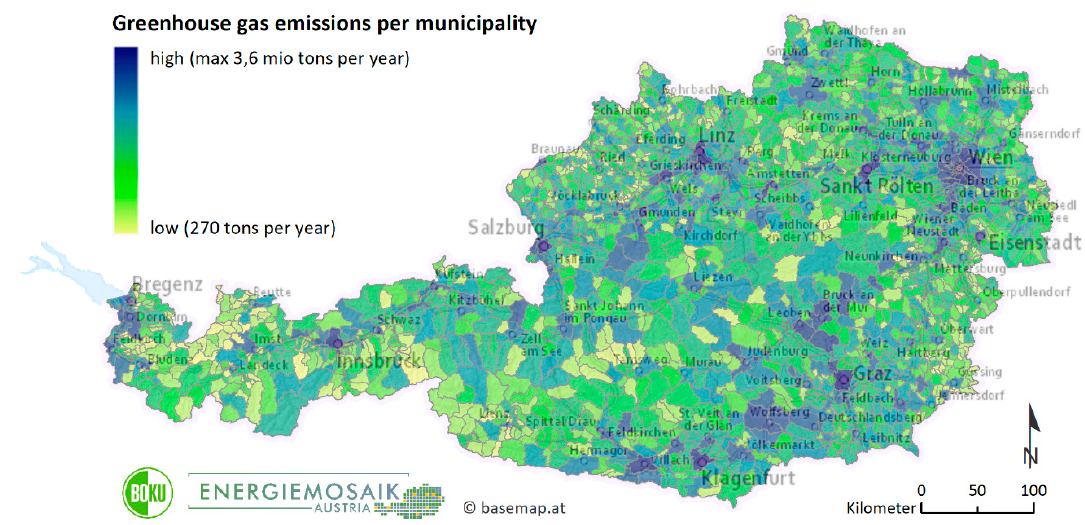
Figure 2. The absolute amount of annual GHG emissions per municipality in tons.